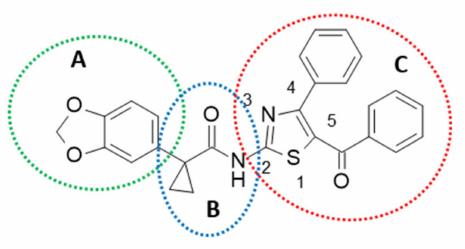
( A ), the substitution of cyclopropane carboxamide moiety ( B ), and the modification of the